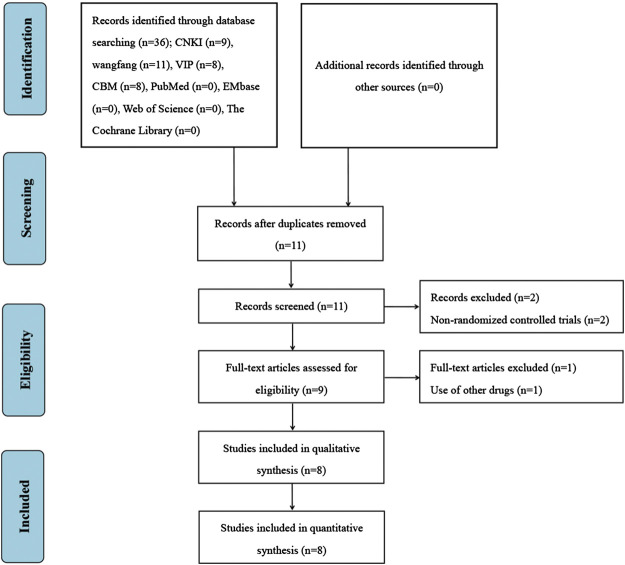
Flow diagram of literature screening.